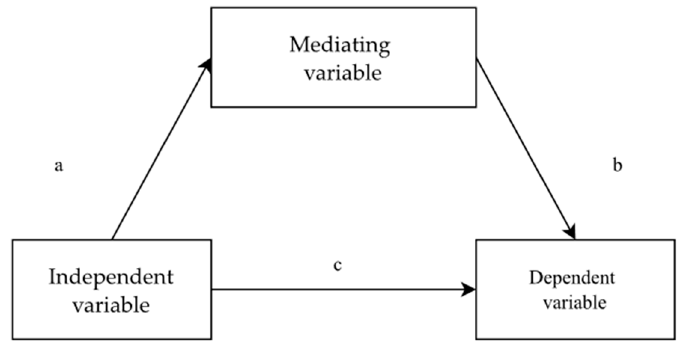
Figure 2. The relation diagram for the mediation model.